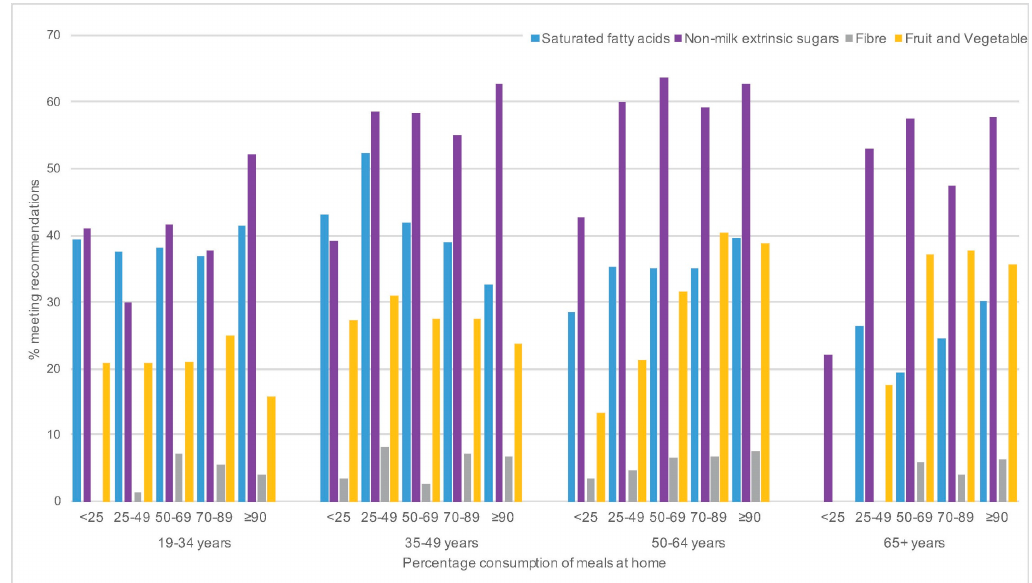
Figure 5. Percentage of adults meeting the recommended intakes of saturated fatty acids, non-milk extrinsic sugars and fibre split by home meal consumption pattern for the NDNS RP Years 1–6 (2008–2014) adult population.